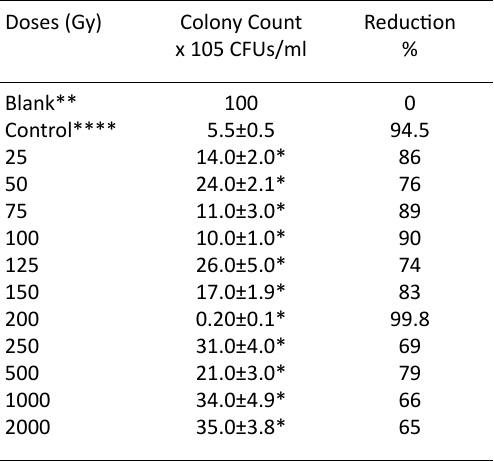
Table 5. Effect of purified penicillin on colony counts (CFUs/ml) of S. aureus Doses